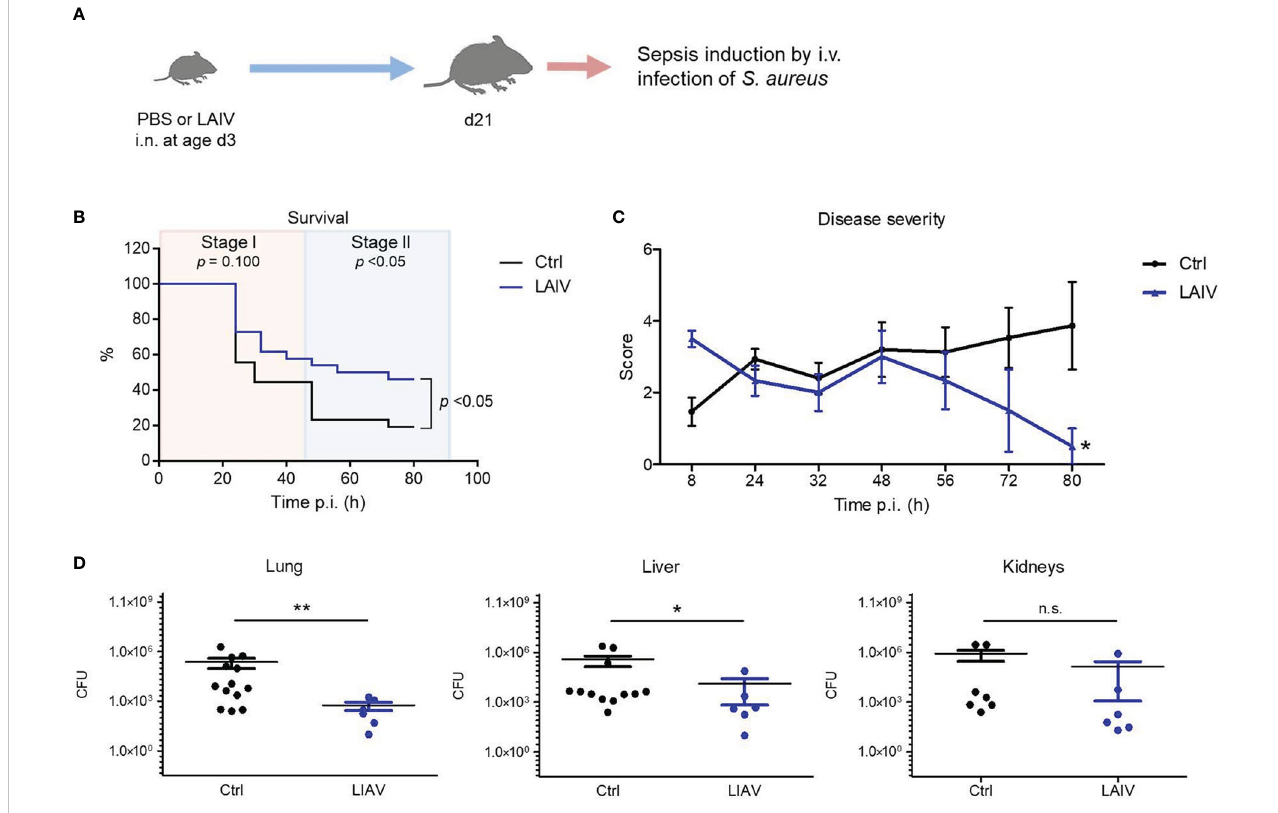
FIGURE 6 Neonatal in fl uenza vaccination improves control of S. aureus infections beyond childhood. Newborn mice were treated i.n. at d3 of life with PBS (Ctrl) or a live-attenuated in fl uenza vaccine (LAIV). After 18 days, sepsis was induced in these mice by i.v. application of S. aureus . (A) Experimental setup. (B) Survival was observed for 80 h p.i. and plotted as percentages over time. n.s., not signi fi cant (Mantel-Cox test). (C) Clinical scores assigned at indicated time points p.i.,plotted as means ± SEM. *p< 0.05 ( post hoc 2-way ANOVABonferroni test) (Ctrln = 52 from 7 litters, LAIV n = 26from4 litters). (D) Bacterial burden was determined in independent experiments inindicated organs80 h p.i. (each group n = 6-13from3 litters, respectively).Plotted are means ± SEM, *p< 0.05,**p < 0.005